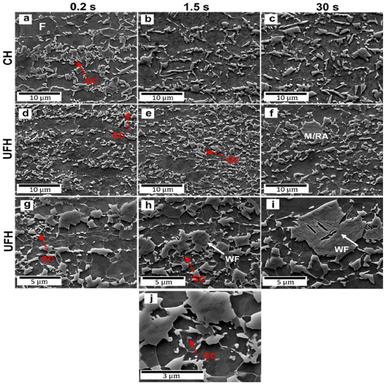
SEM micrographs showing the effect of heating rate (10 and 800 °C/s) and soaking time (0.2 to 30 s) on the microstructure: a), b) and c) correspond to 10 °C/s for 0.2, 1.5 and 30 s, respectively; d), e) and f) correspond to 800 °C/s for 0.2, 1.5 and 30 s, respectively. Higher magnification images g), h) and i) show microstructures heated at 800 °C/s for 0.2, 1.5 and 30 s, respectively; j) higher magnification image of spheroidized cementite (SC) in the sample heated at 800 °C/s for 1.5 s. Spheroidized cemen